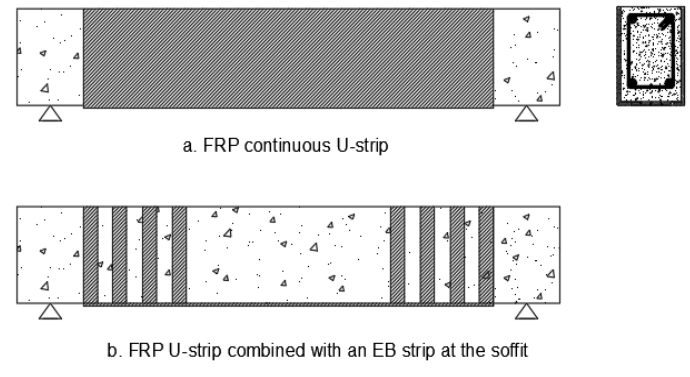
Figure 4. Hybrid Strengthening systems.